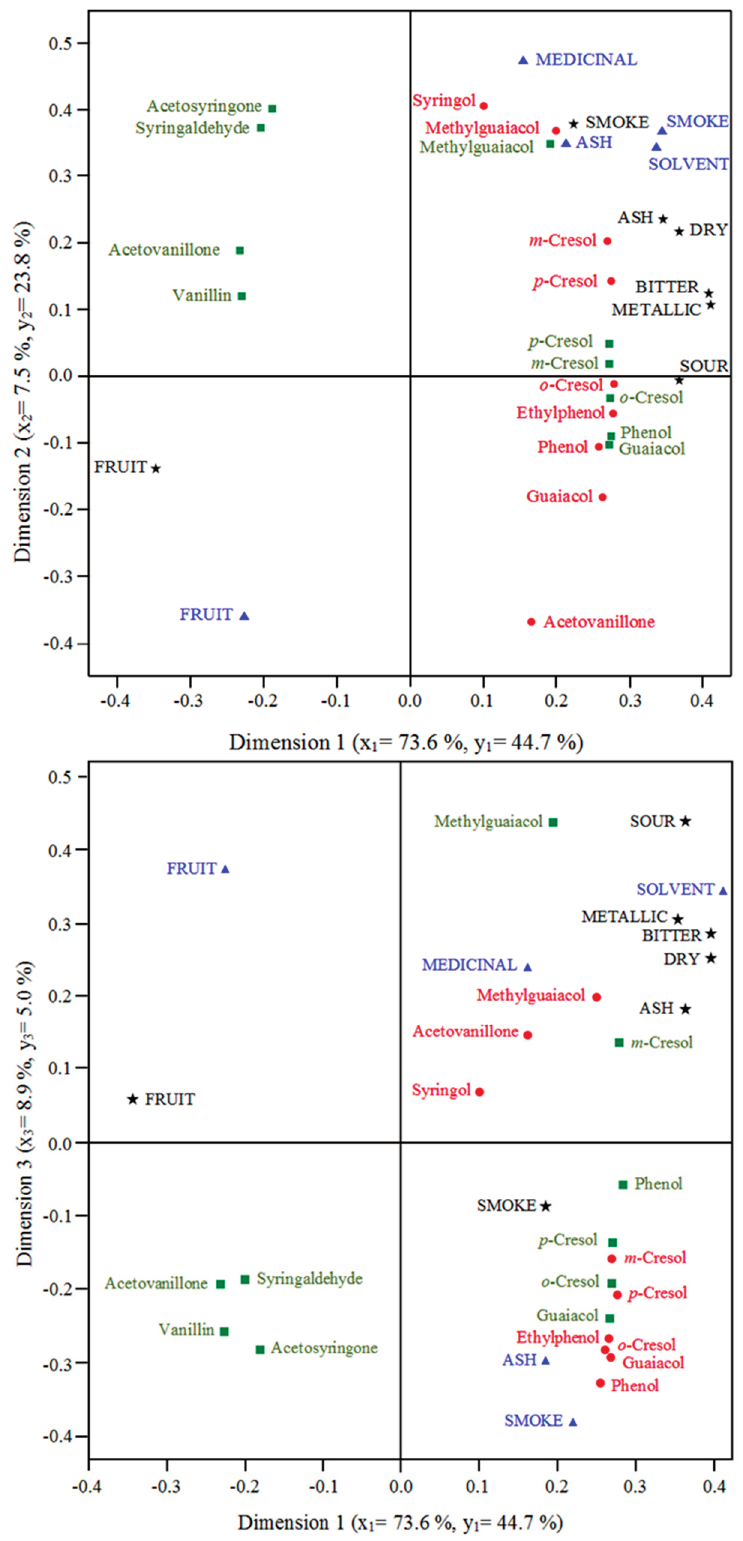
Figure 4. Correlation loading biplots (of loadings and scores) from partial least square regressions analysis of wine phenol composition and sensory attributes. Wine phenol composition (x i ) with glycoconjugated phenols (green squares) and volatile phenols (red circles). Wine sensory attributes (y i ) with aroma attributes (blue triangles) and taste attributes (black